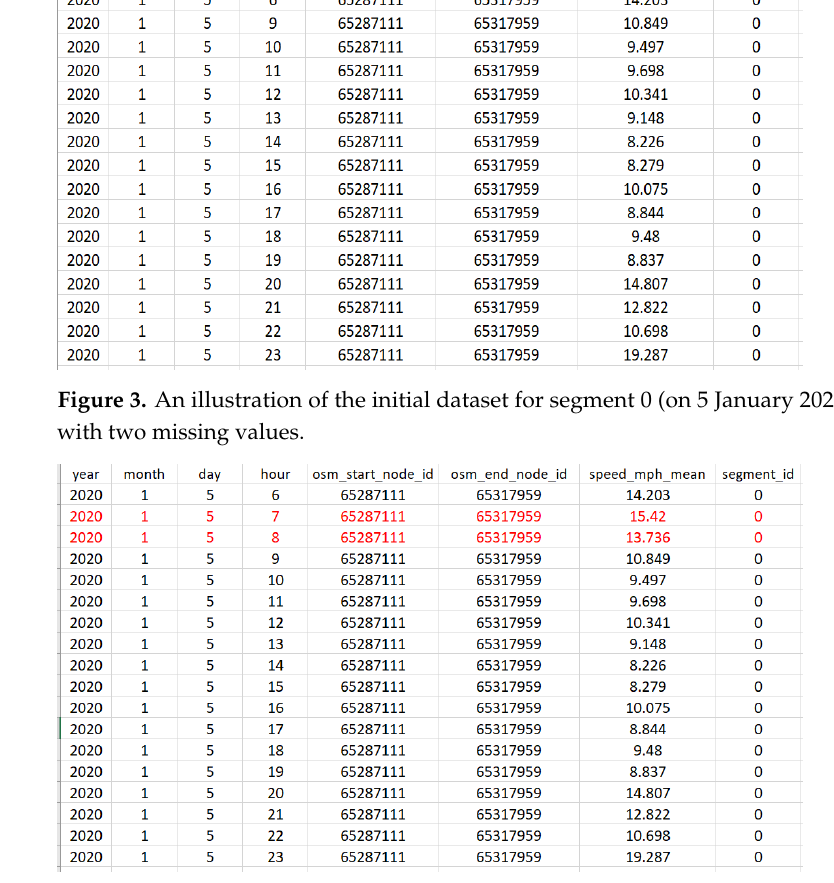
Figure 4. An illustration of the final dataset for segment 0 (5 January 2020, from 6:00 to 24:00) where the two missing values (shown in red color) were calculated using